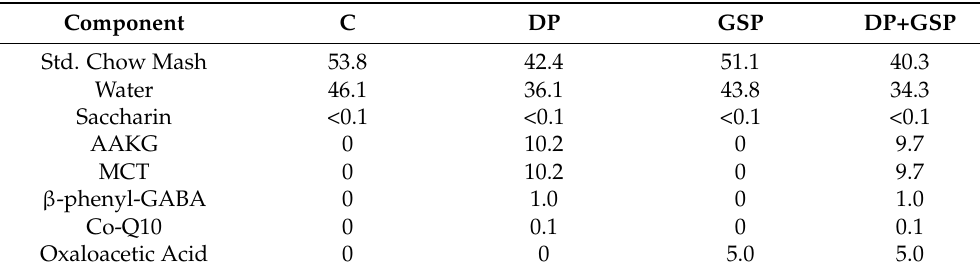
Table 2. Diet composition. Percentages of each dietary component by weight are shown. The caloric density of C, DP, GSP, and DP+GSP diet preparations were 1.67, 2.60, 1.58, and 2.47 kcal/g., respectively. Abbreviations: Std., standard; AAKG, arginine-alpha-ketoglutarate; MCT, medium- chain triglyceride oil; Co-Q10, coenzyme Q 10 . Component C DP GSP DP+GSP Std. Chow